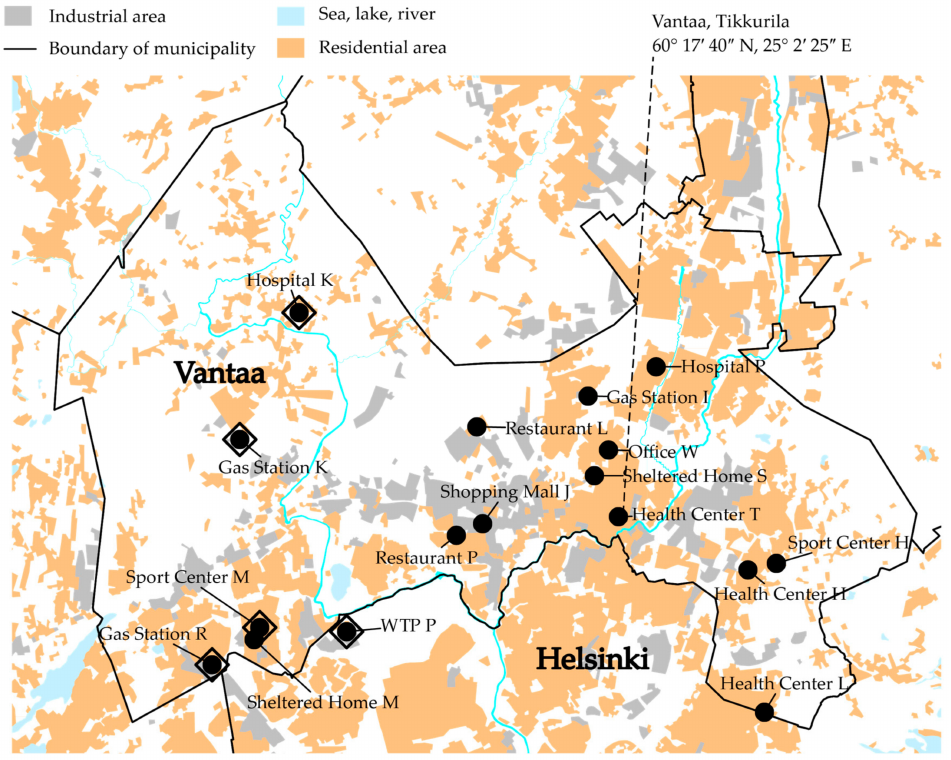
Figure 1. A map of the study area. The black circles are obligatory monitoring locations and the large open diamonds are sampling campaign